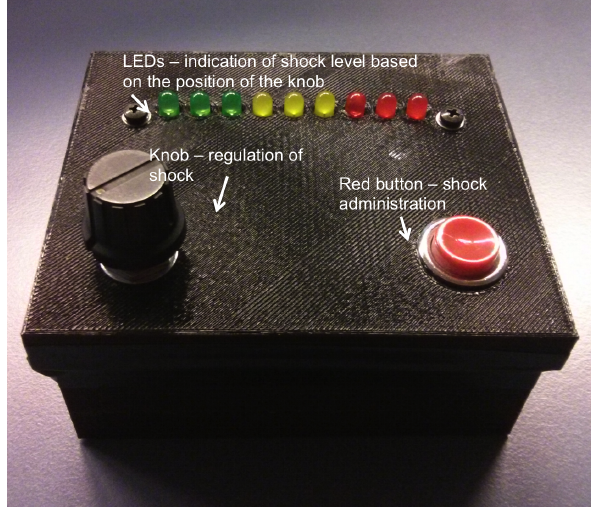
Figure 10: Image of the shock generator. The shock generator has a turnable knob that regulates the amount of shock indicated by the colored LEDs. The red button is used to administer the shock to the